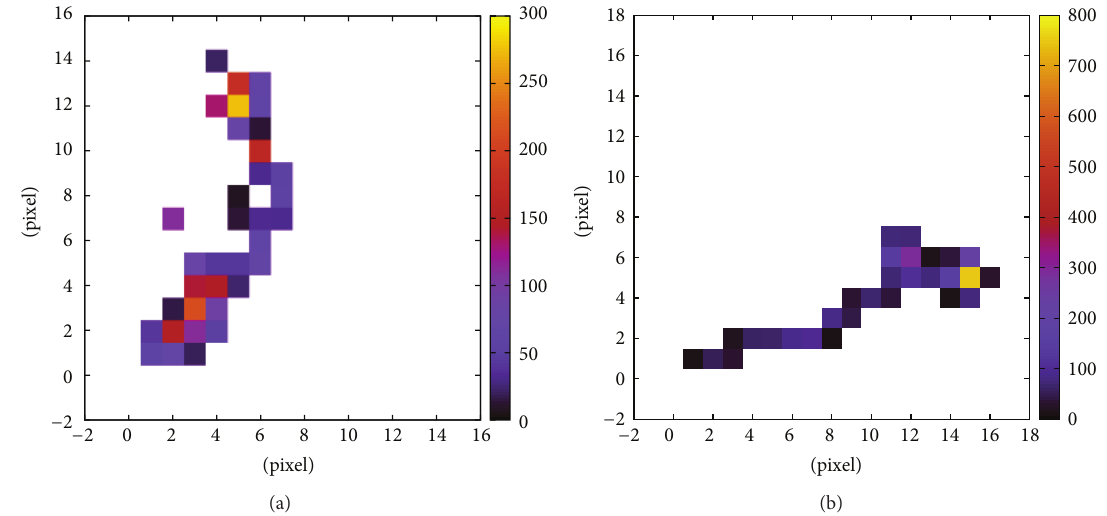
Figure 11: Simulated pattern of energy depositions in the pixel matrix of single electrons with energy deposition close to 𝐸 𝑄 . (a) Electron that has an appearance similar to a 0 ] 𝛽𝛽 -decay event. (b) Electron track like it is expected in a naive picture. The 𝑥 - and 𝑦 -coordinates give the pixel row and column. The color bar encodes the energy deposition measured with the time-over-threshold method in